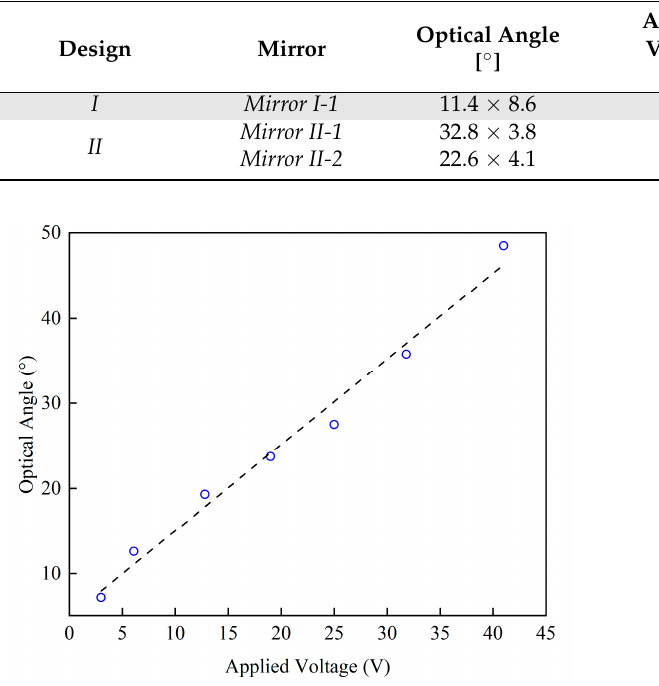
Figure 9. ( a ) Schematic diagram of the scanning platform. ( b ) The built platform and the scanning results of Design I and Design II. Table 3. Biaxial scanned laser beam characteristics.